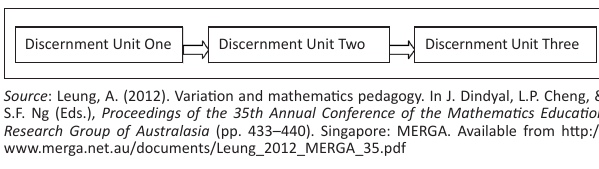
FIGURE 2: A pedagogical time sequence on the understanding of a mathematical object of